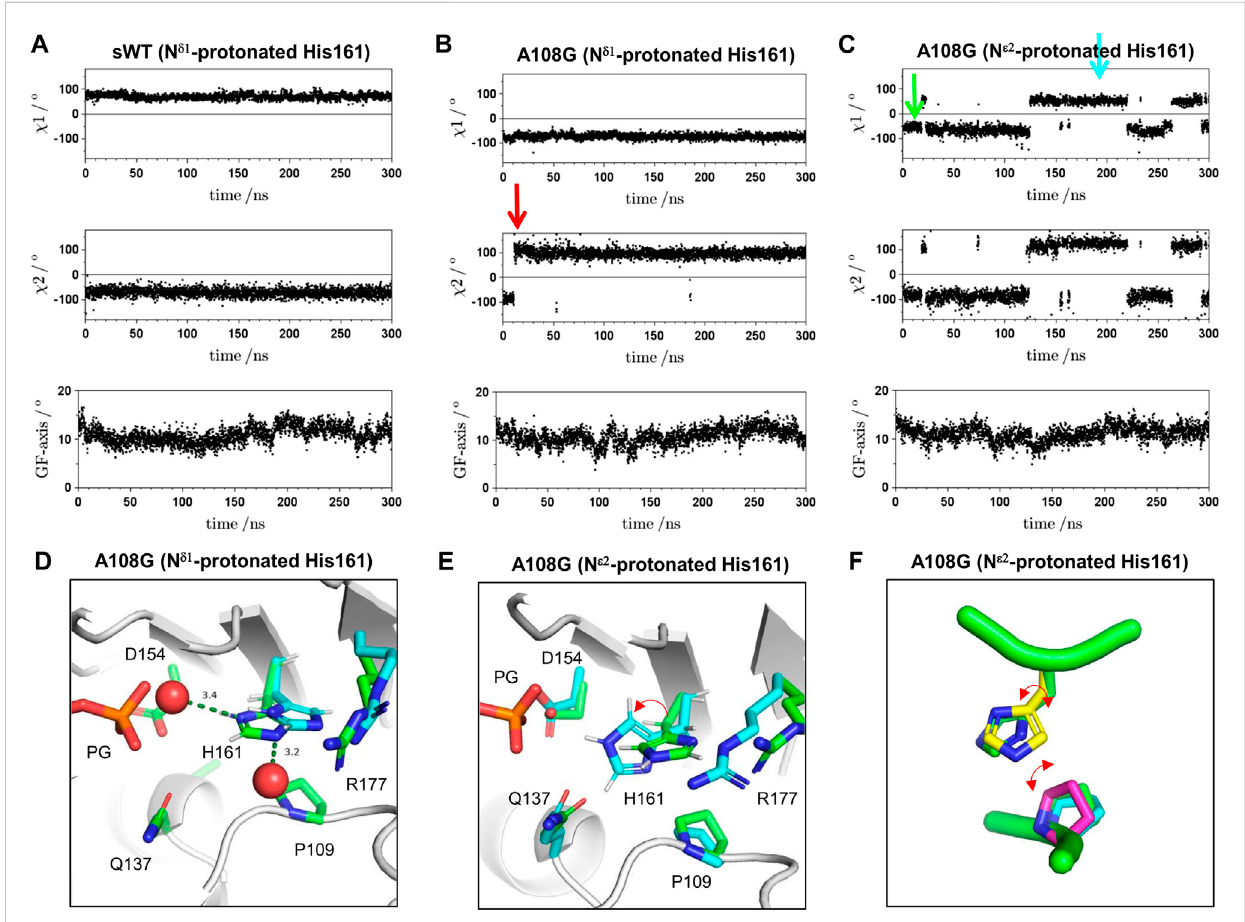
FIGURE 5 Timecoursefor χ 1 angle, χ 2 angleofHis161,andGF-axisvalueduringMDsimulation. (A) TypicaltraceforMDsimulationontheF1/sWTcomplex.The GF-axis value expresses the degree of F-form in global molecule conformation and corresponds to the angle of fl attering; the mean angle values of F-form and G-form are 15 ° and 4.5 ° , respectively (Oda et al., 2019). Positive and negative χ 1 angle values indicate gauche-plus, fl ipped con fi rmation and gauche-minus, non- fl ipped con fi rmation, respectively. χ 1 angle is ~69 ° ( fl ipped conformation). χ 2 angle expresses the rotation of the imidazole ring of His161 and is maintained at ~ − 71 ° . (B) Typical trace for MD simulation on F1/A108G complex with N δ 1 -protonated His161 ( δ -tautomer). The simulation showedtheimidazoleringinvertedimmediatelyaftertheinitiationoftheMDsimulation(redarrow)andthenmaintainedtheupside-downorientation; χ 2 angle is ~ − 87 ° for 1 – 10 ns and is ~96 ° for 20 – 300 ns. However, the χ 1 angle is kept to ~ − 73 ° (non- fl ipped conformation). (C) Typical trace for MD simulation on the F1/A108G complex with N ε 2 -protonated His161 ( ε -tautomer). The χ 1 angle is ~ − 63 ° at 20 – 120 ns/260 – 290 ns (non- fl ipped conformation) and ~43 ° at 120 – 220 ns ( fl ipped conformation). The χ 2 angle in the fl ipped conformation is ~105 ° (upside-down), whose value is different from that in the F-form of WT. (D) Active site of A108G in the F1/A108G complex with N δ 1 -protonated His161 ( δ -tautomer). Crystal structure re fi ned at upside-down H161 (green) and MD structure after 300 ns (cyan). The two structures were pair- fi tted by the main chain atomsof Gly108, Pro109, Gln137, Asp154, His161, and Arg177. (E) Snapshots of MD simulation on the F1/A108G complex with N ε 2 -protonated His161 ( ε -tautomer) at 10 ns (green arrow in panel C) and 180 ns (cyan arrow in panel C). The two structures were pair- fi tted by the main chain atom of Gly108, Pro109, Gln137, Asp154, His161, and Arg177. During the MD simulation, the fl exible side chain of Arg177 frequently dissociated from the binding site. The side chain of Arg177 appeared occasionally to restrict the ring fl uctuation of His161. The red arrow shows the correspondence between two states and is not the rotational direction of the fl ipping. (F) ConformationsofPro109andHis161observedintheMDsimulationonA108G( ε -tautomer).SidechainsofPro109(cyan: ϕ = − 65 ° and φ = 143 ° , magenta: ϕ = − 83 ° and φ = 175 ° , where ϕ and φ are the dihedral angles of G108) were drawn on the crystal structure of A108G (A108G_AMPPNP, green: ϕ = − 75 ° and φ = 153 ° ). The structures were aligned using the C α s of residues 108 – 110 and 160 – 162. The side chains of Pro109 and His161 in the crystal do not collide with each other. However, when the side chain of His161, χ 2 , inverts in the non- fl ipped conformation (yellow; χ 1 = − 77.8 ° and χ 2 = 83.4 ° ), which was very rarely observed in the MD simulations, the two side chains (yellow one and magenta one)